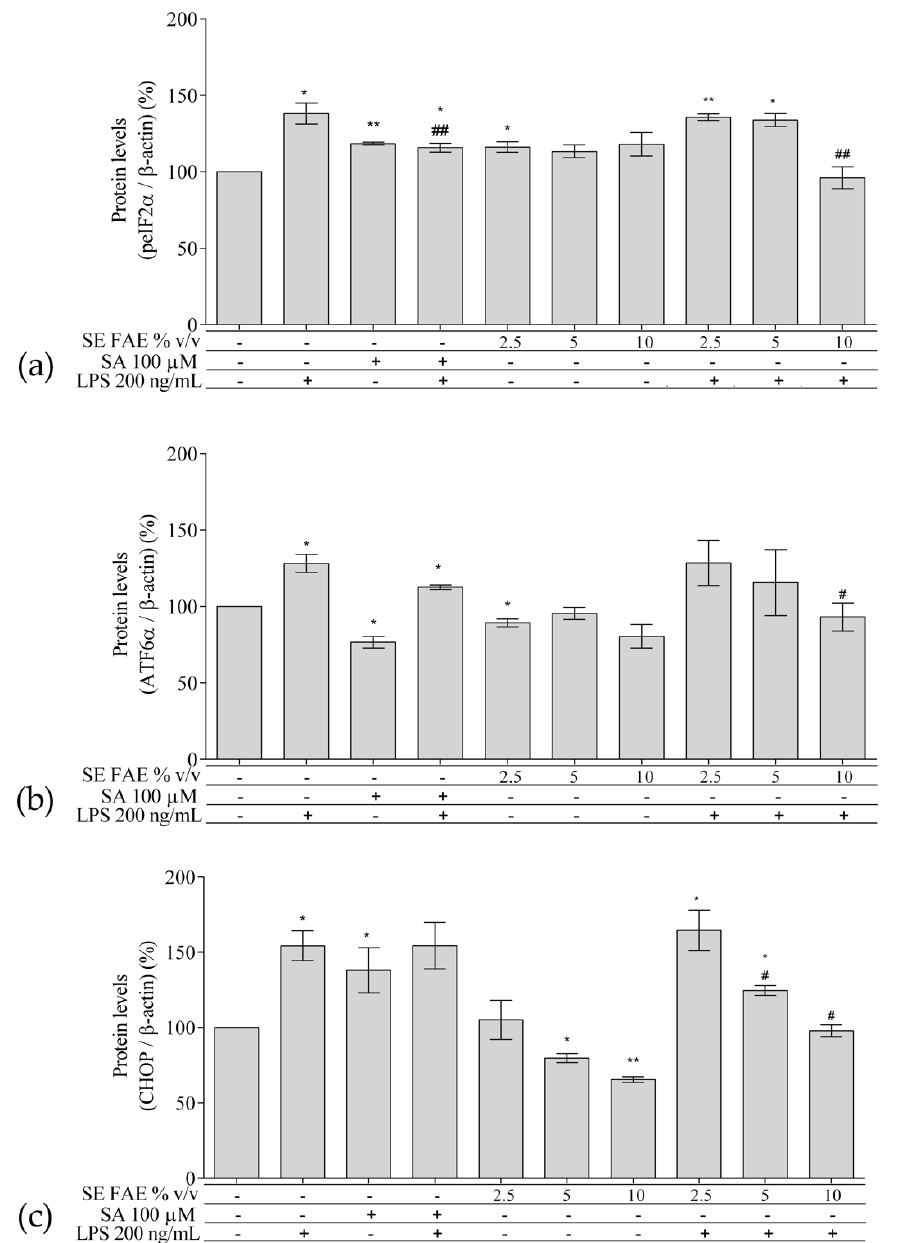
Figure 5. Changes in the protein levels of peIF2 α ( a ), ATF6 α ( b ), and CHOP ( c ) in J774A.1 mouse macrophages pre-treated with increasing concentrations (2.5%, 5%, 10% v / v ) of SE FAE or with SA for 24 h and subsequently stimulated or not with LPS. Results were obtained using the Western blot technique. Data are presented as mean ± SEM. Legend: SE FAE– Sambucus ebulus L. fruit aqueous extract; SA–100 µ M salicylic acid; LPS–200 ng/mL lipopolysaccharides. * p < 0.05, ** p < 0.01 vs. untreated cells; # p < 0.05, ## p < 0.01 vs. LPS treatment.